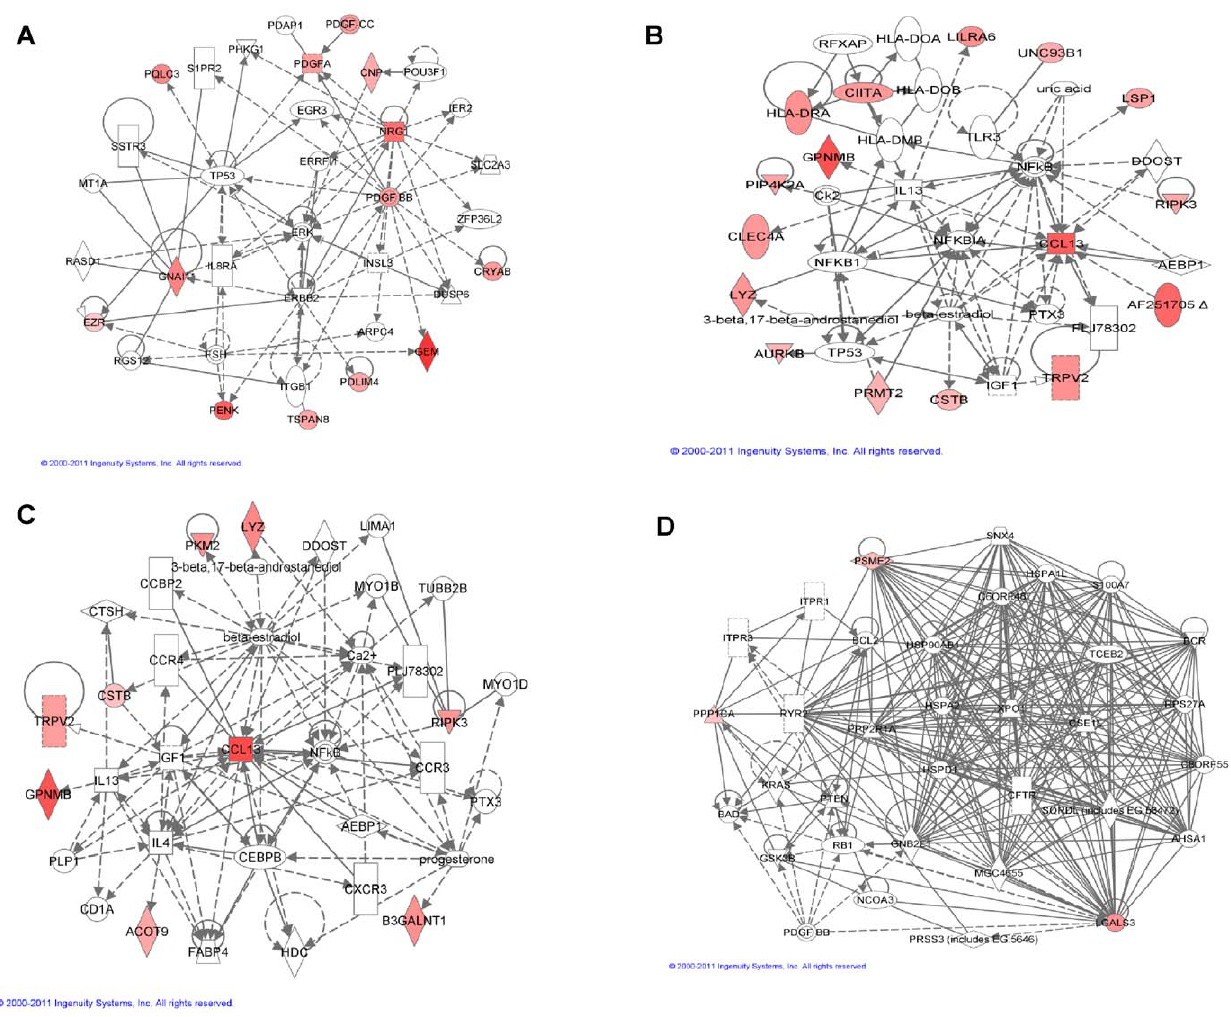
Figure 4. Ingenuity Pathway Analysis (IPA) for the enriched biological functions of the top 20 genes for each signature. The involved genes are highlighted in the red color. The lines between genes represent known interactions, with solid lines representing direct interactions and dashed lines representing indirect interactions. The high scores associated with these networks indicate they were highly unlikely to be formed by chance. ( A ) 11 out of the top 20 genes for BDH signature are involved with p53 and ERBB2 pathways (Network 1, Cancer, Cell Cycle, Cell Death, score of 28), and ( B ) 17 out of the top 20 inflammation signature genes are involved with inflammatory pathway NF k B (Network 1, Immune Response, Cell- To-Cell Signaling and Interaction, Connective Tissue Disorders, score of 47). ( C ) 9 of the top 20 genes for the necrosis signature are also involved with Immune Response pathway, majorly NF k B complex, and ( D ) 3 of the top 20 genes for necrosis are associated with cell death (Network 2, Cancer, Cell Death, Cell Cycle, score of